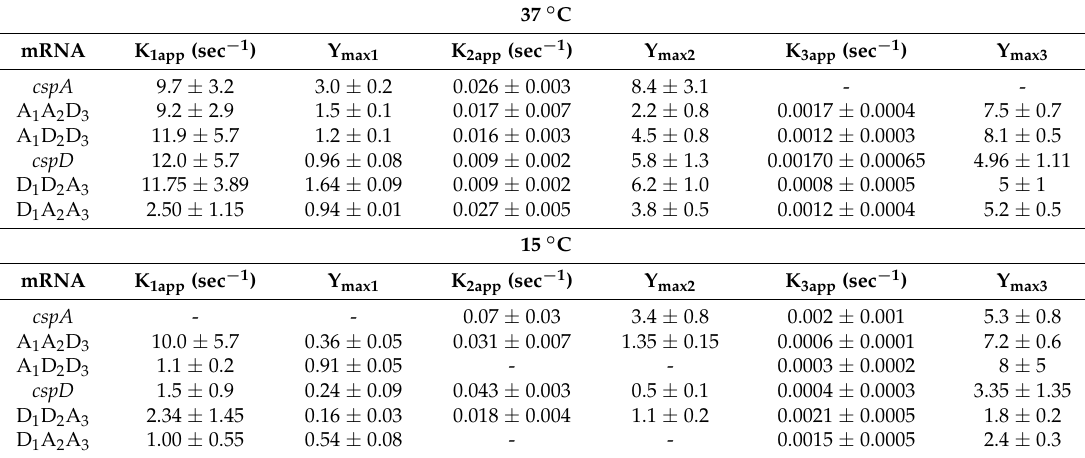
Table 2. Apparent rate constants (K app ) of 30S IC formation monitored by f[ 35 S]-Met-tRNA binding at the indicated